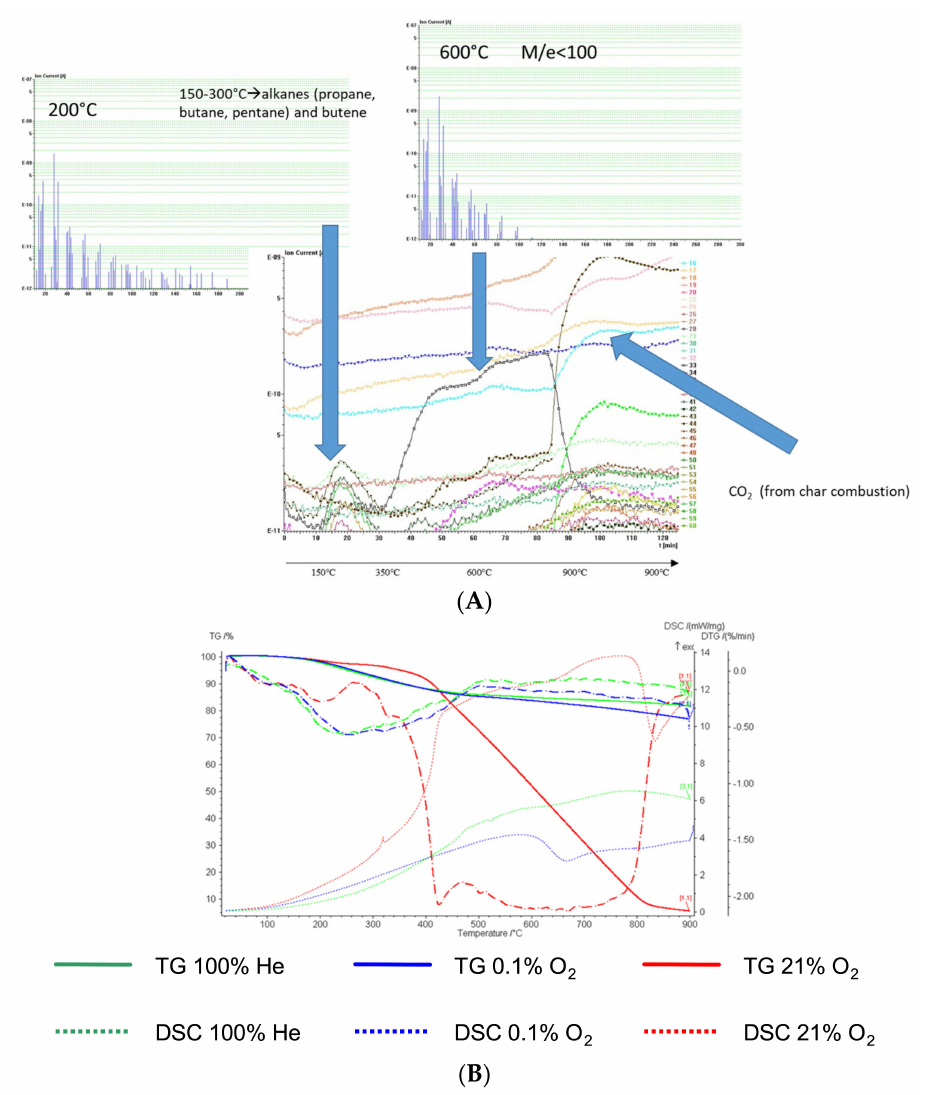
Figure 14. ( A ): TG–MS results of NI–TG analysis of RW in He (MS spectra at 200 ◦ C and at 600 ◦ C are shown); ( B ):TG–DSC results of NI-TG analysis of RW in He, in 0.1% O 2 in He and with 21% O 2 in He (adapted from [22] with